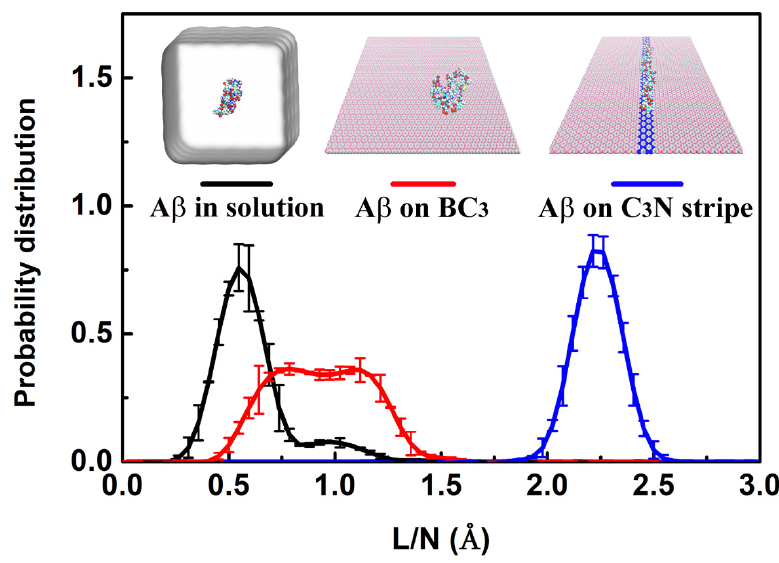
Figure 3. Probability distribution of end-to-end distances for A β in solution (black line), on BC 3 surface (red line), and on C 3 N stripe (blue line).